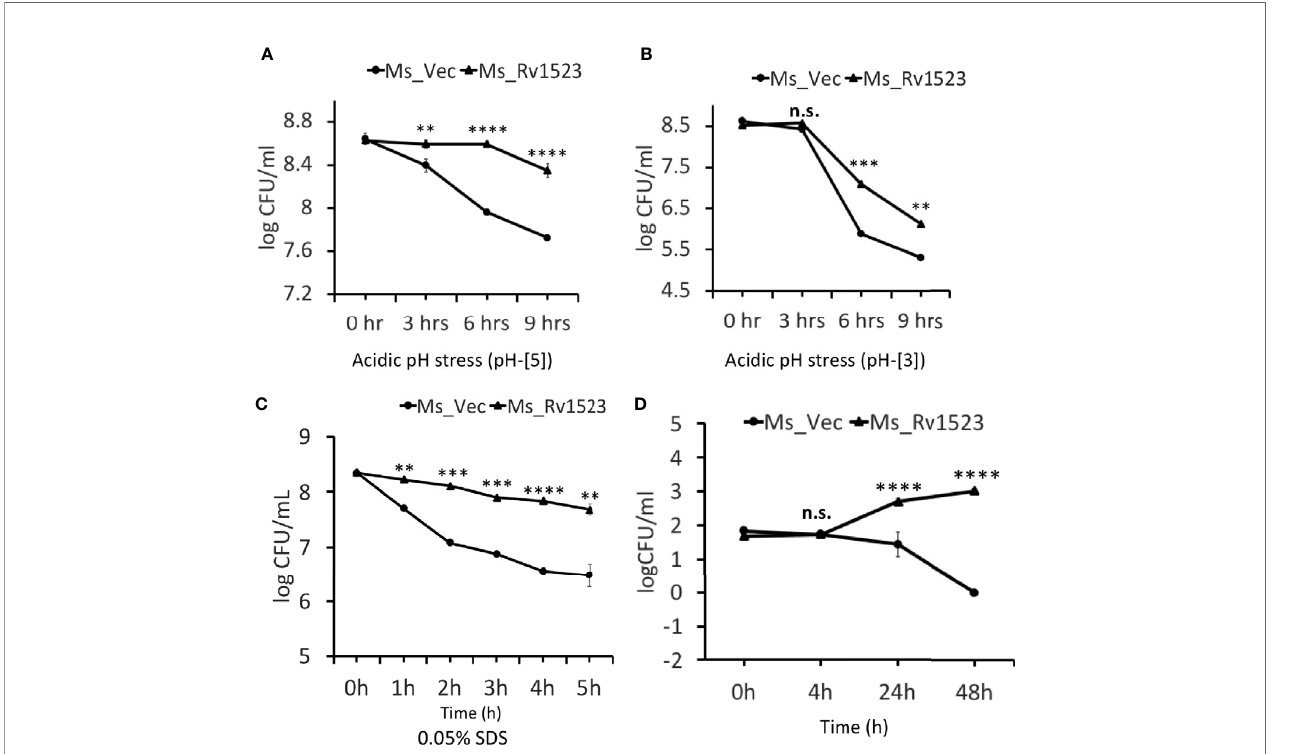
FIGURE 4 | Rv1523 expression in M. smegmatis causes resistance to antimicrobial stress factors. The growth of Ms_Vec and Ms_Rv1523 after treatment, for various times, with different pH gradient pH-[3] (A) and pH-[5] (B) . Cultures of Ms_Vec and Ms_Rv1523 were harvested, re-suspended to 5 ml 7H9 media at an OD 600 of 0.6, 10-fold serial dilutions of Ms_Vec and Ms_Rv1523 were spotted on 7H10 agar plates. Ms_Rv1523 was more resistant to acidic pH stress at both the pH gradients pH-[3] and pH-[5] as compared to Ms_Vec. (C) Ms_Rv1523 was observed to be ~100 – 1,000 fold resistant to the surface stress as compared to Ms_Vec. For surface stress analysis mid-log-phase cultures of Ms_Vec and Ms_Rv1523 were incubated in 7H9 media supplemented with 0.05% SDS for indicated time. The recombinant strains were plated onto 7H10 agar plates after serial ten-fold dilution. Bacterial numbers were counted after 3 – 4 days of growth. (D) Expression of M. tuberculosis Rv1523 in M. smegmatis increased 100 – 1,000 fold intracellular survival within macrophage. Mouse RAW264.7 cells were infected with Ms_Vec and Ms_Rv1523 at an MOI of 10:1. After 4, 24, and 48 h infection, macrophages were washed and lysed using 0.01% SDS. Lysates were plated on 7H10 medium to enumerate the CFU count. Two-way ANOVA was used for calculating statistical signi fi cance. All the experiments were performed at least three times; SEM is represented by error bar for biological triplicates. ns, non-signi fi cant, **p < 0.01, ***p < 0.001, and ****p <